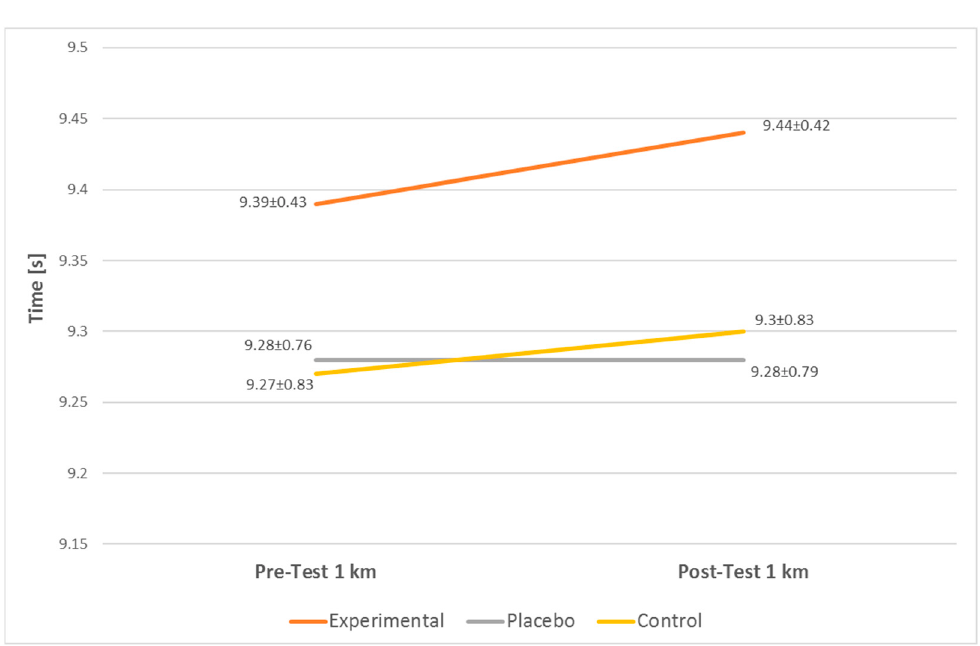
Figure 4. 40 m shuttle run results.